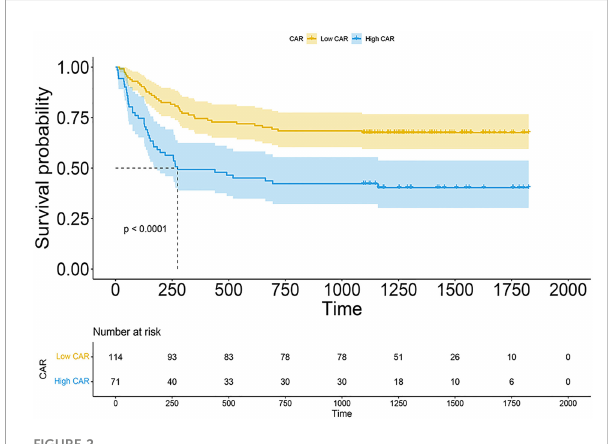
FIGURE 2 Kaplan – Meier plots of OS according to patient groups with low CAR or high